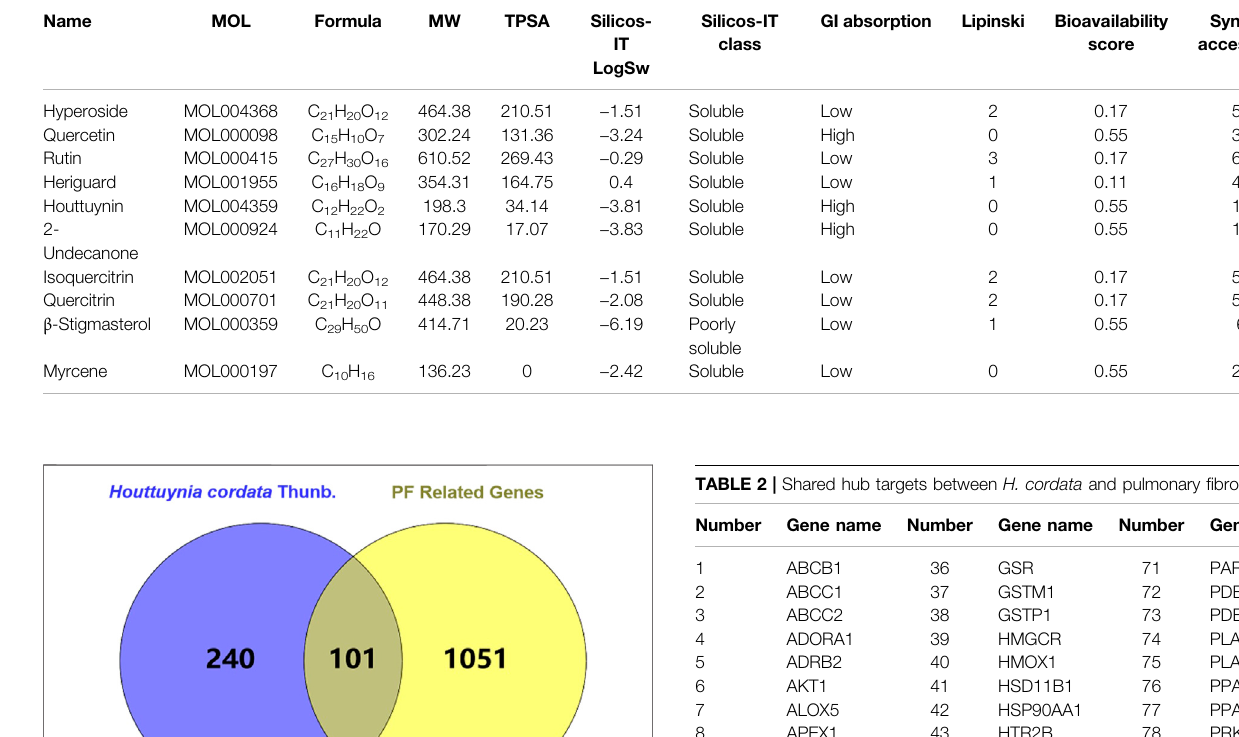
TABLE 1 | Main chemical constituents of H. cordata .